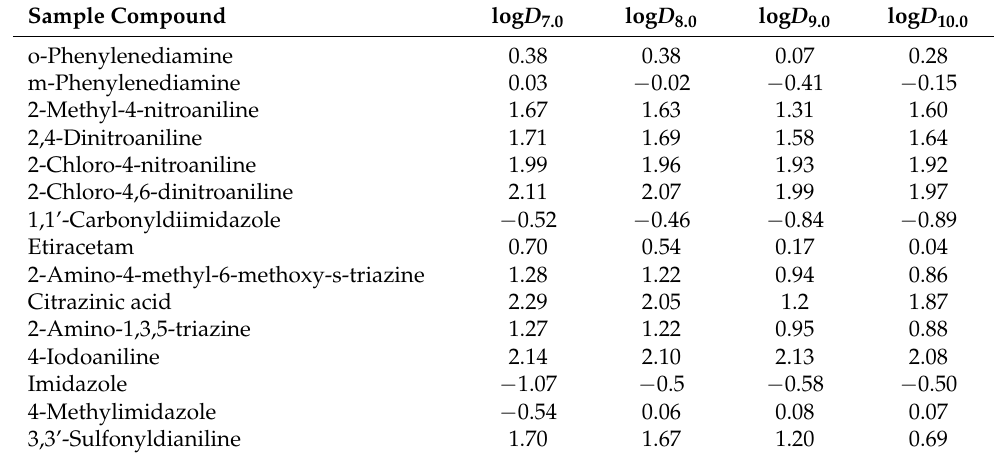
Table 5. log D values of the sample compounds at pH 7.0, pH 8.0, pH 9.0, and pH 10.0 determined using